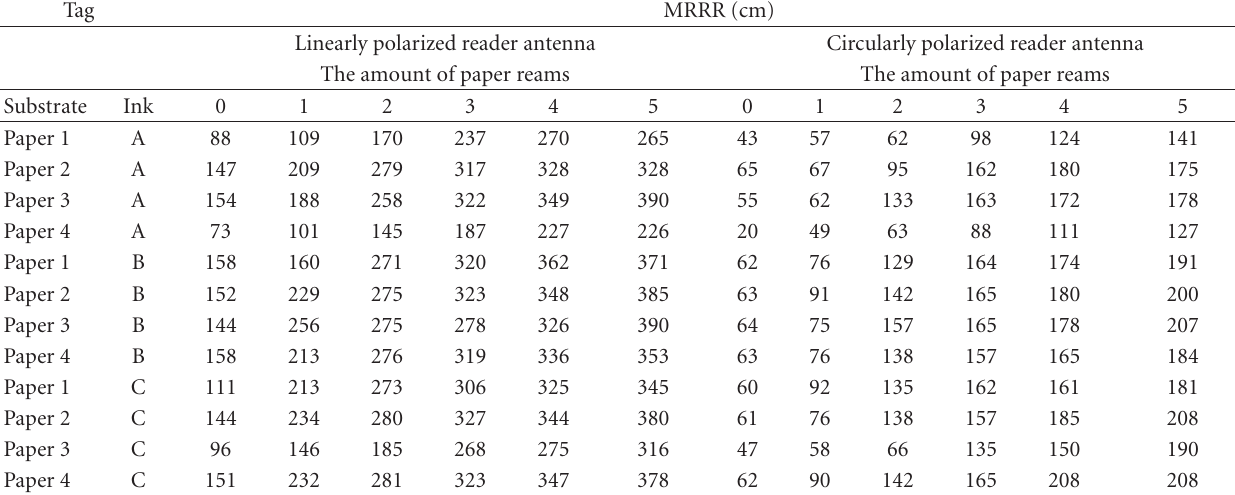
Table 7: The e ff ect of paper reams in front of the tag on the MRRR values.